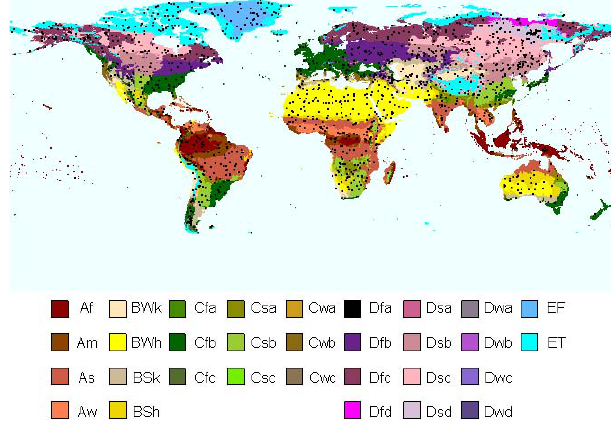
Fig. A1. Global map of K¨oppen–Geiger climate types derived from the WATCH Forcing Data set over the period 1958–2001 by Wanders et al. (2010). Black dots indicate a total of 1495 locations used in this